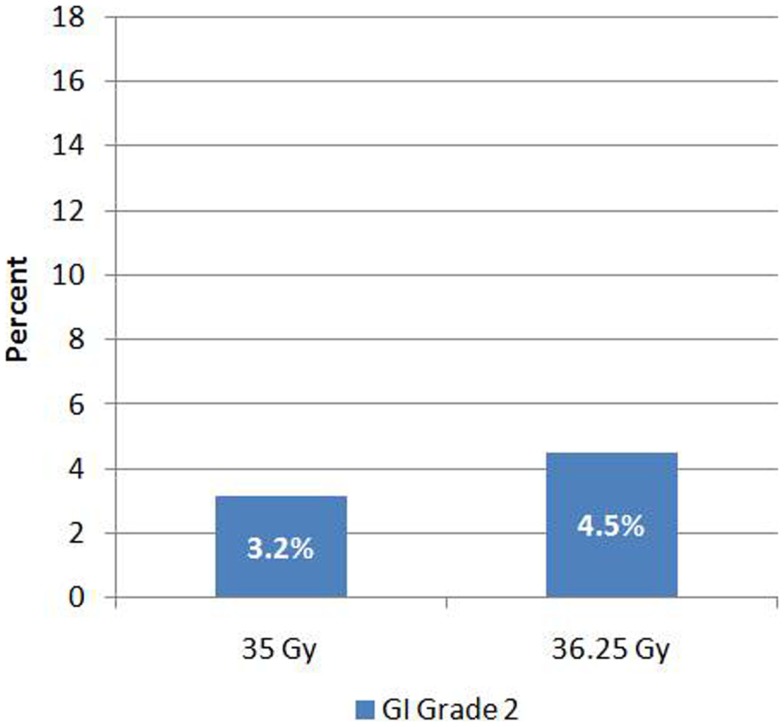
Gastrointestinal toxicity by dose.